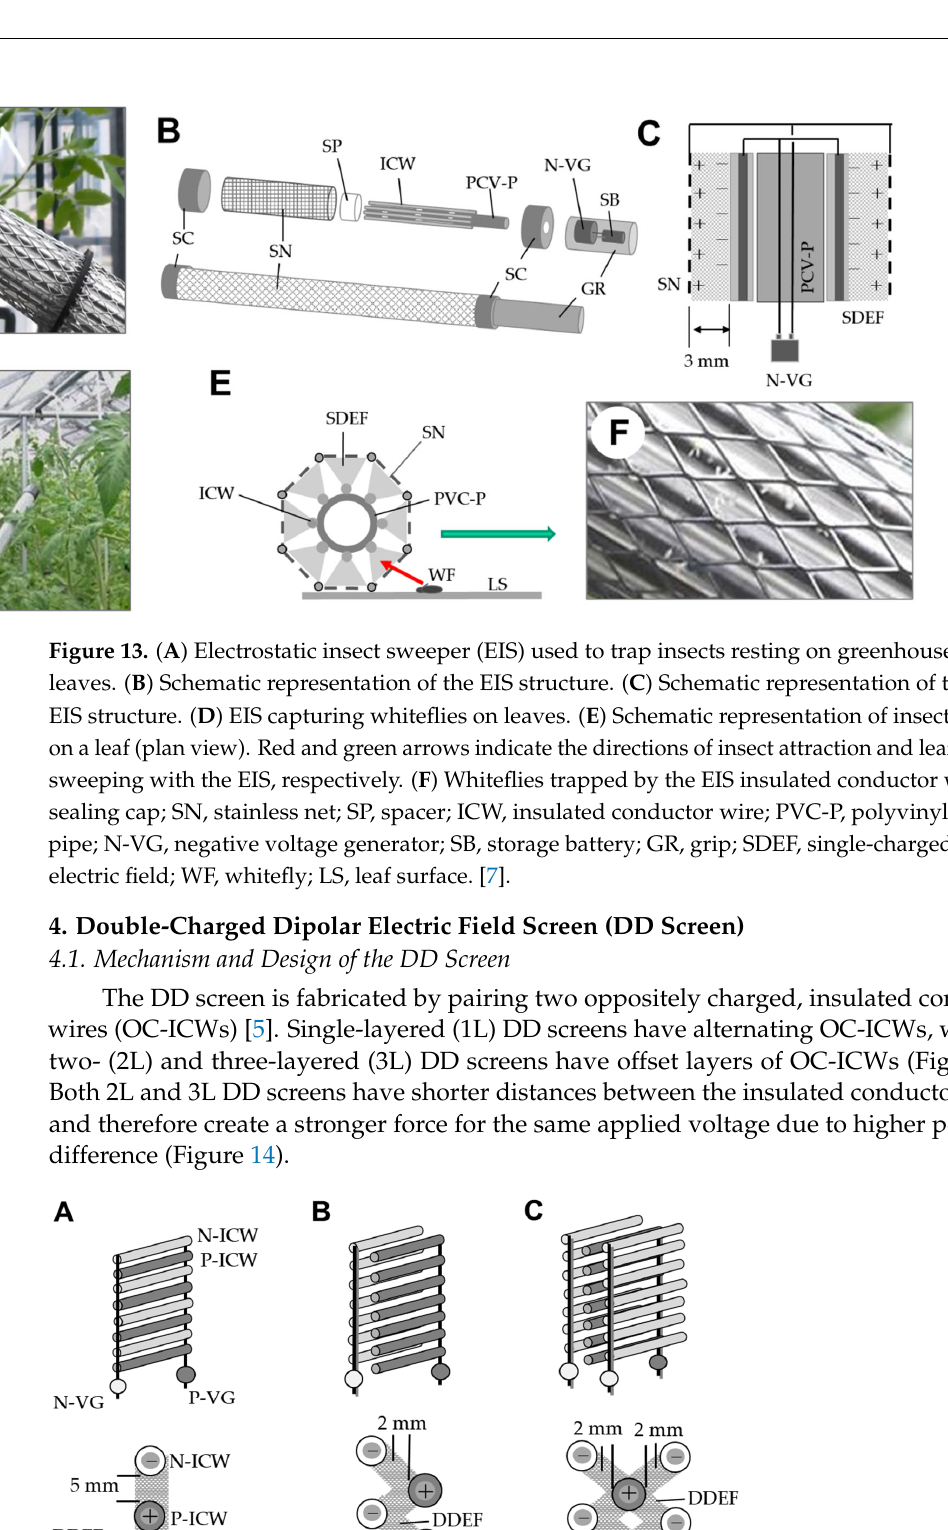
Figure 15. Schematic representation of the insect capture mechanism of the DD screen. ( A ) DDEF pro ‐ duced by two oppositely charged insulated conductor wires. Free electrons in the air are attracted to the positive pole. ( B ) Insect capture by the negative pole. The insect was positively electrified by dis ‐ charge ‐ mediated positive electrification and then attracted to the negative pole. Free electrons (red arrow) in the insect were released and attracted to the positive pole. ( C ) Insect capture by the positive pole. The insect was negatively electrified by free electrons around the positive pole and then attracted to the positive pole (charge ‐ mediated negative electrification). N ‐ ICW, negatively charged insulated conductor wire; P ‐ ICW, positively charged insulated conductor wire; DDEF, double ‐ charged dipolar electric field; PE ‐ I, positively electrified insect; NE ‐ I, negatively electrified insect [39]. When an insect enters the DDEF, it can be captured in one of two ways, either by losing free electrons to become positively electrified in the space near the NC ‐ IC (negative pole) and being attracted to the negative pole, as in an SDEF device (Figure 15B), or by receiving electrons accumulated around the positively charged pole and being negatively electrified (Figure 15C) [39].